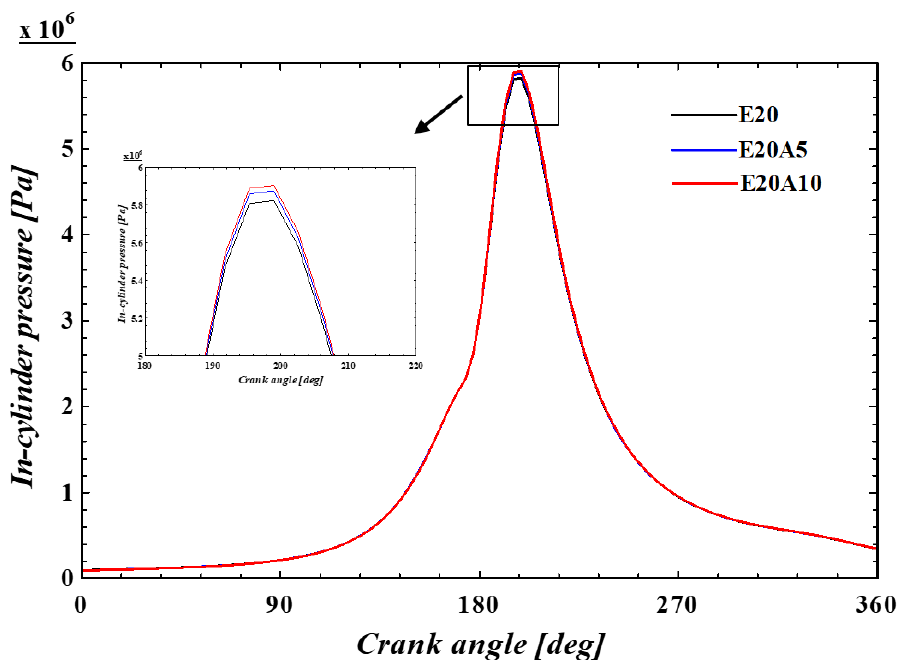
Figure 9. The in-cylinder pressure in various crank angles at engine rated RPM.